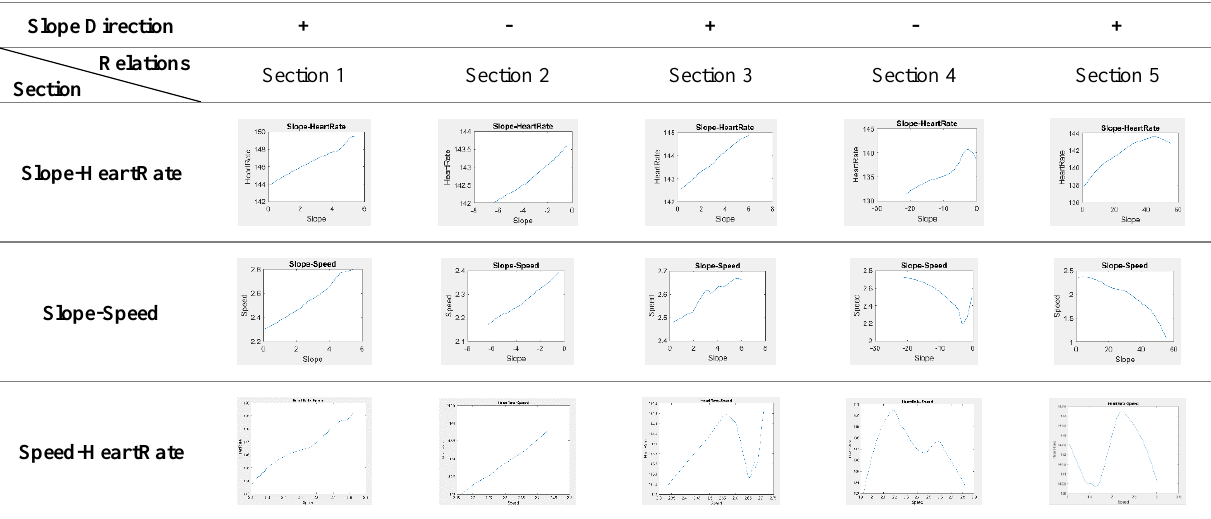
Table 1. Graphs of relation between spatial parameters (Slope) and non-spatial parameters (Heartrate and Speed).